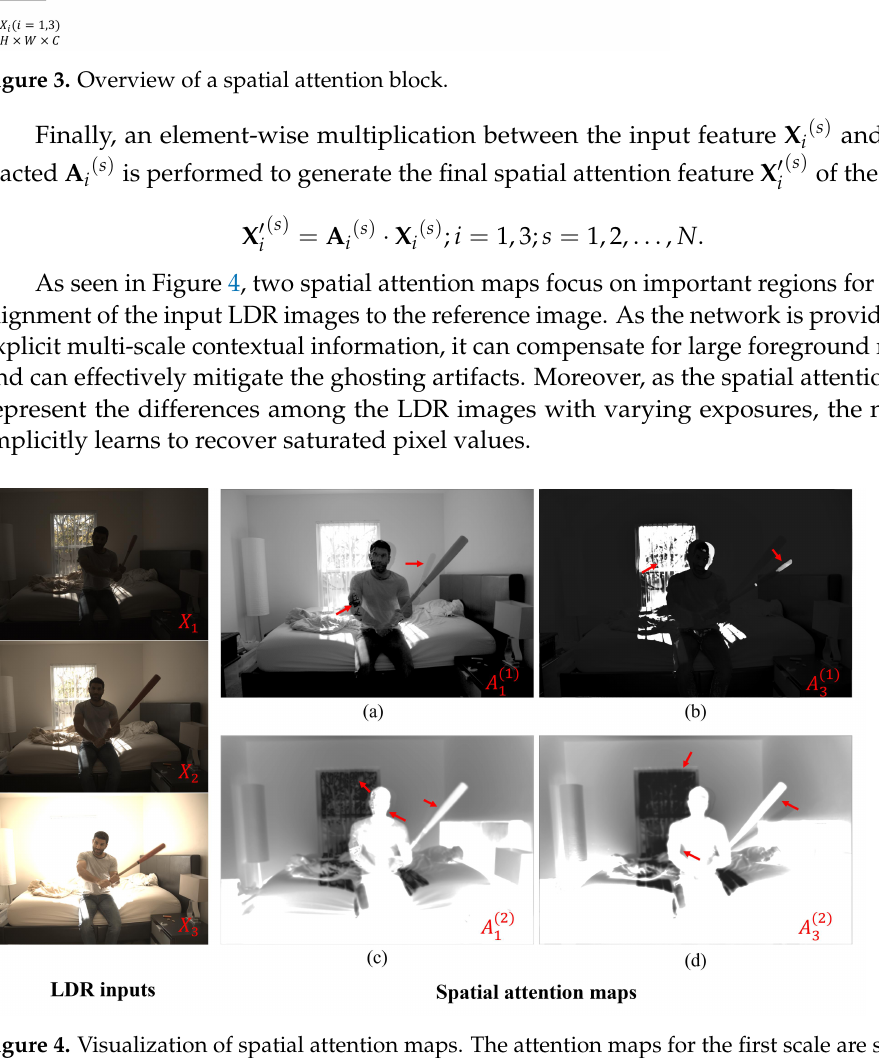
Figure 4. Visualization of spatial attention maps. The attention maps for the first scale are shown in ( a , b ). The attention maps for the second scale are shown in ( c , d